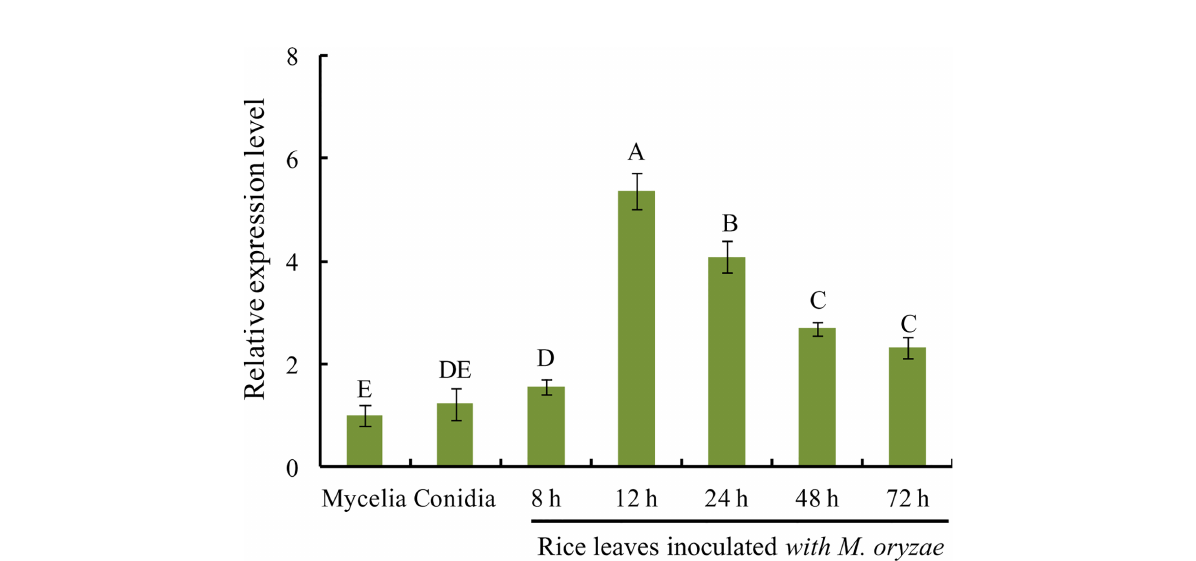
FIGURE 6 RT-qPCR analysis of MoVcpo expression at different developmental and infective stages. The fungal constitutive gene Moactin was used as internal reference. Values are the means ( ± SE) based on three independent experiments and bars indicate standard deviations. Different letters indicate statistical signi fi cance ( p < 0.05) using Duncan ’ s new multiple range